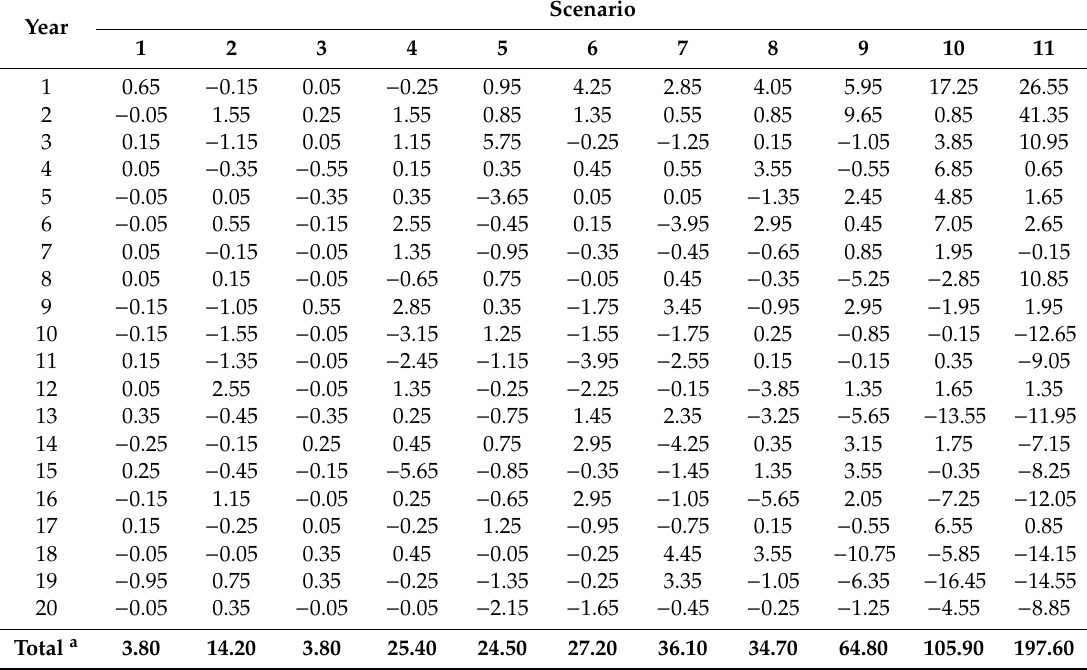
Table 6. Deviations from the area target (ha) when using the regeneration